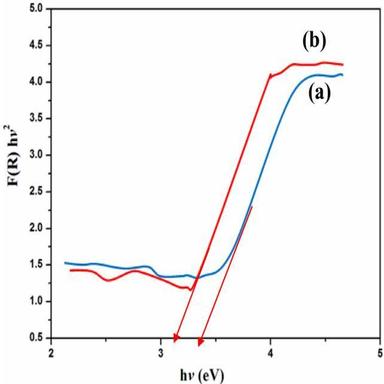
UV–Vis DRS analysis(a)SnO2 (b)CdO-SnO2 nanocomposite material.